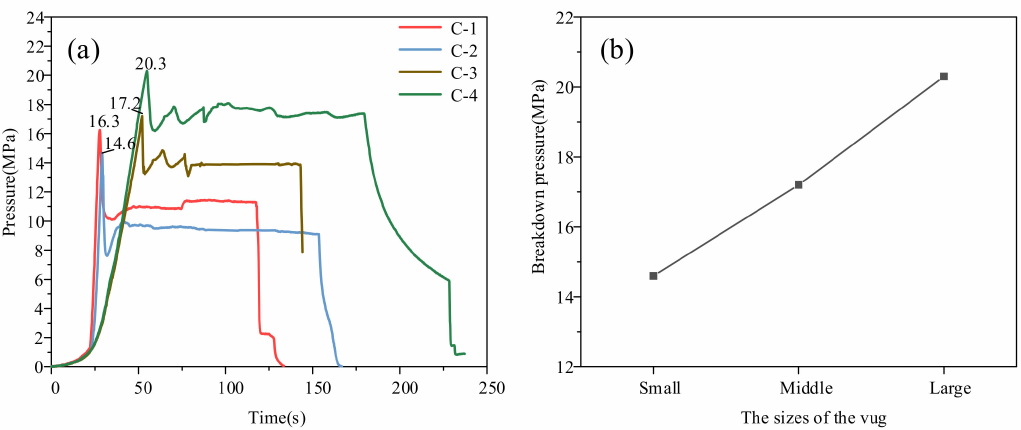
Figure 10. Pressure curves and breakdown pressures for different vug sizes: ( a ) pressure curves and; ( b ) breakdown pressures.